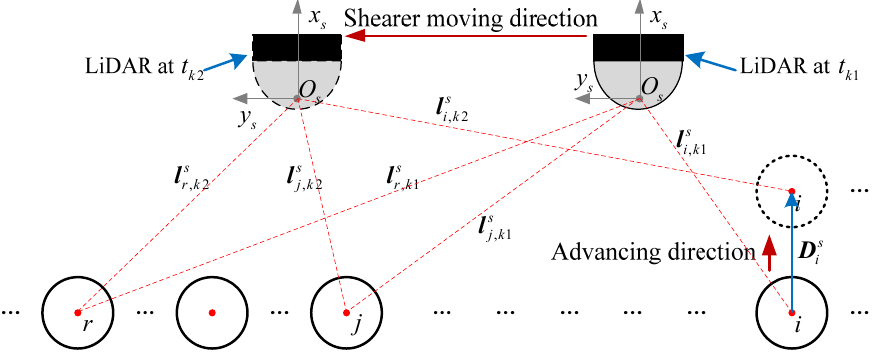
Figure 6. Schematic diagram of the spatial relationship between the LiDAR and the features.